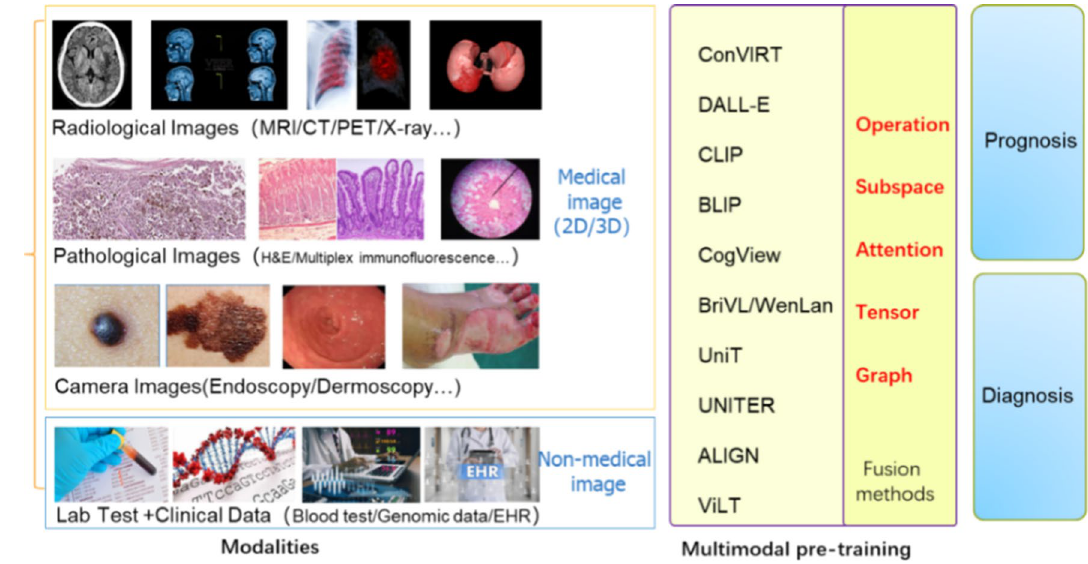
Fig. 1 Scope of discussion in this